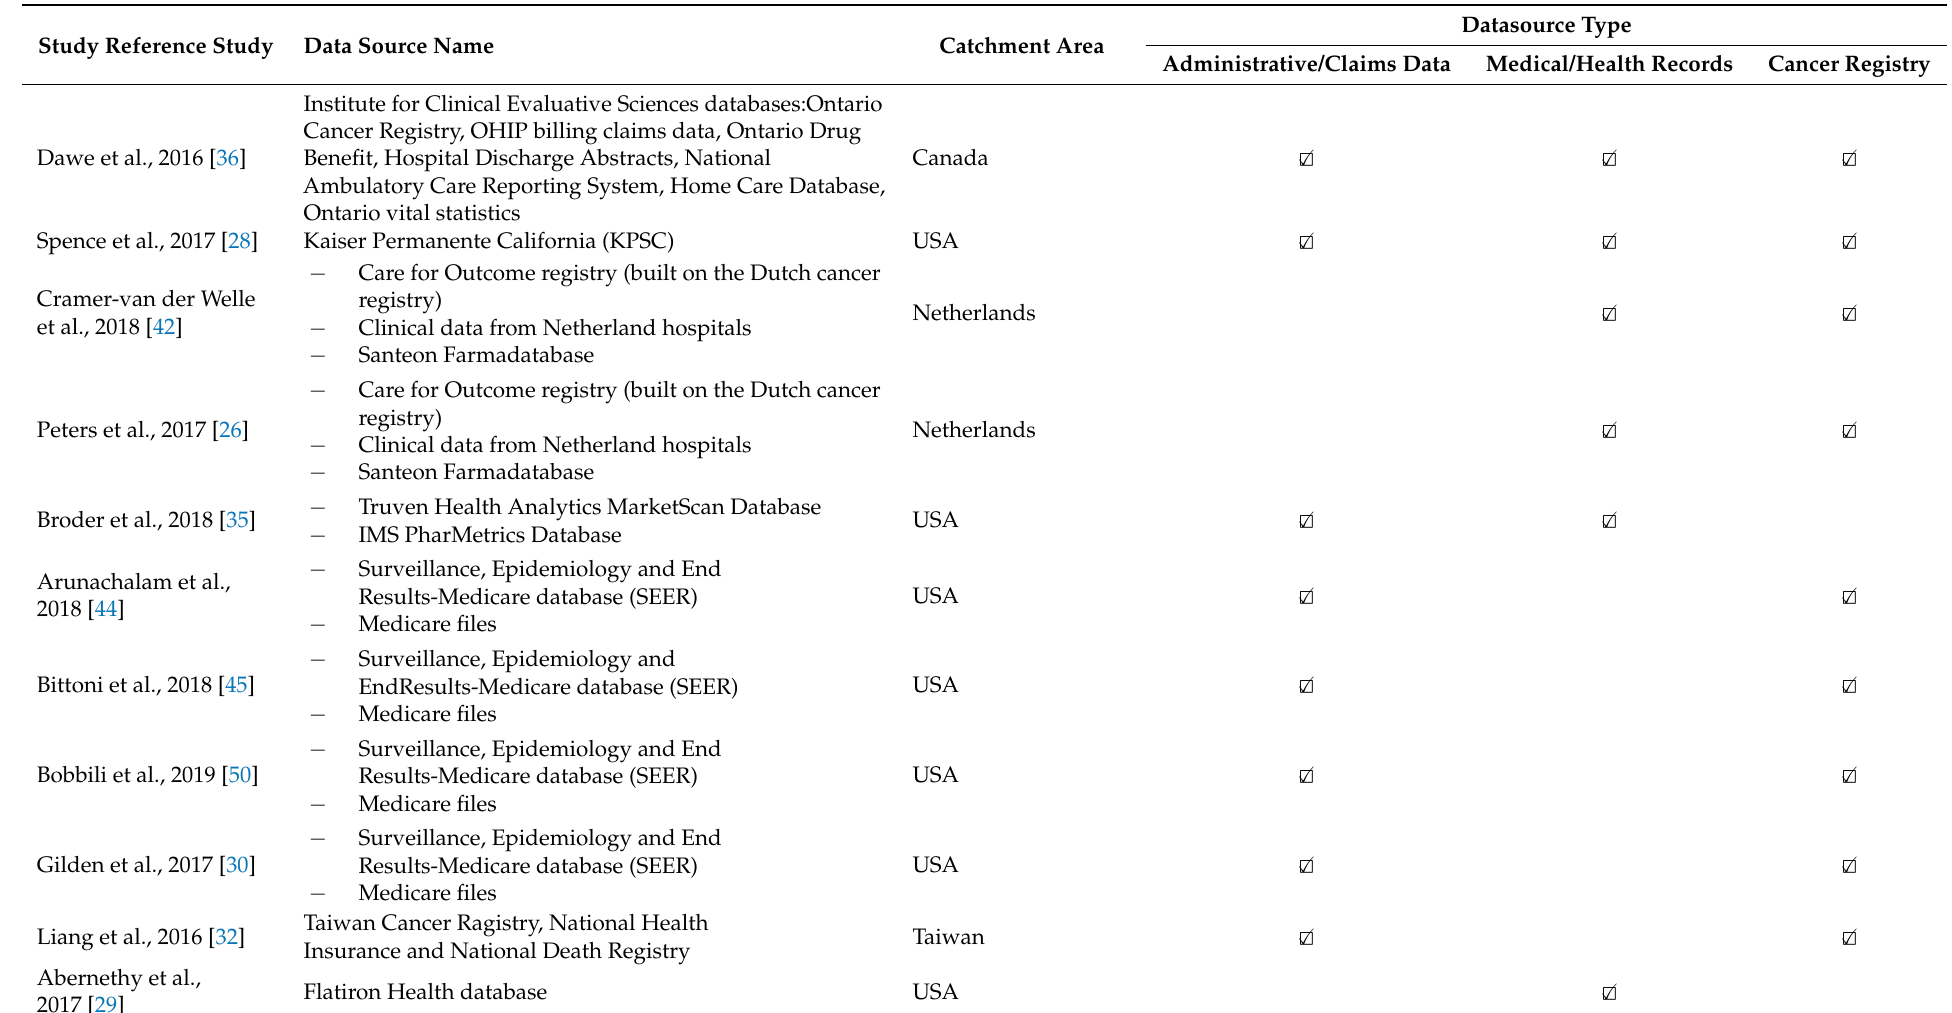
Table 1. Data source